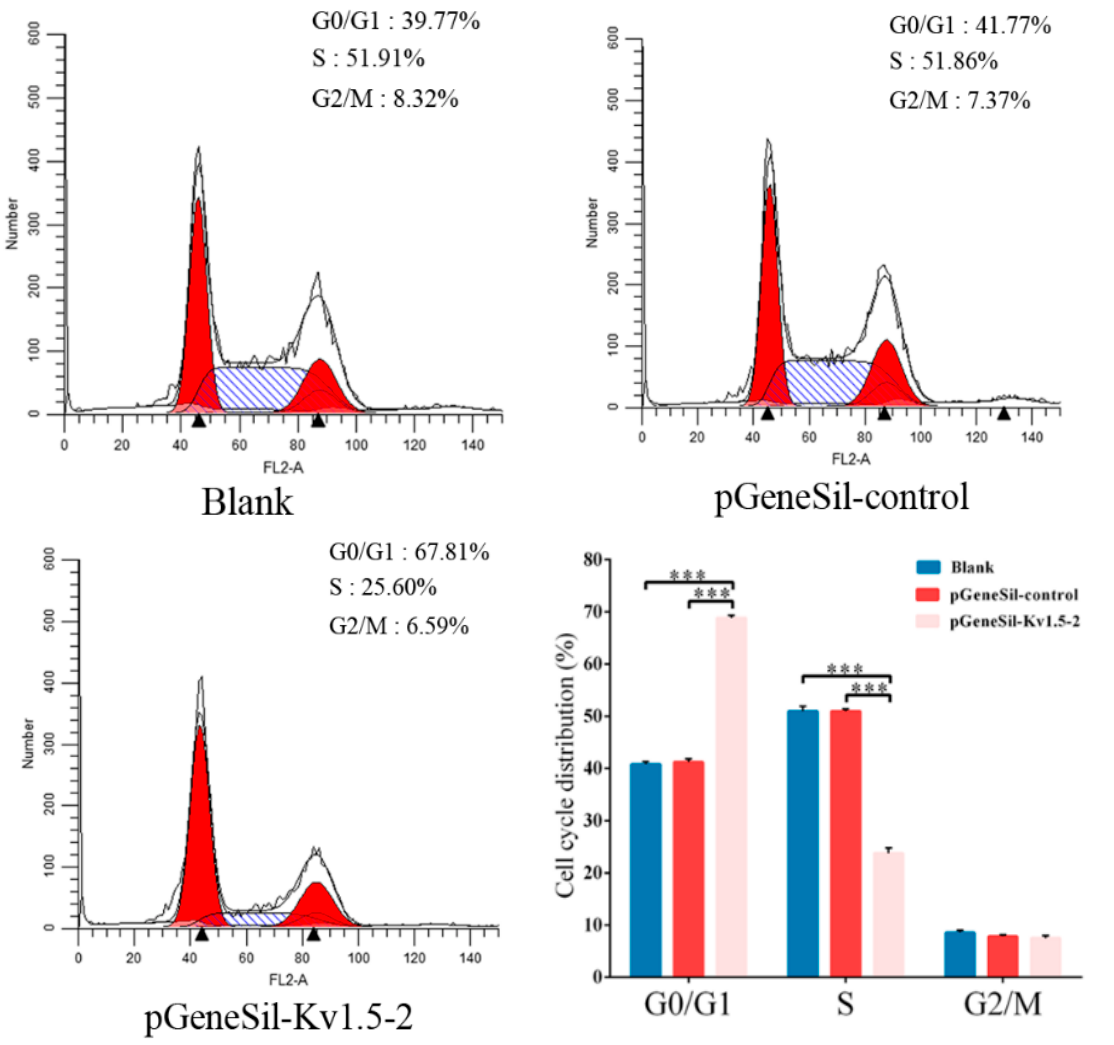
Figure 4. The effects of Kv1.5 knockdown on the progression of cell cycle. Cells were transfected with control-shRNA, or Kv1.5-shRNA, or left untreated for 48 h. Kv1.5 silence induced a significant increase in cells arrested in the G0/G1 phase and a decrease in cells arrested in the S phase. Representative images of each group were shown. *** p < 0.001.